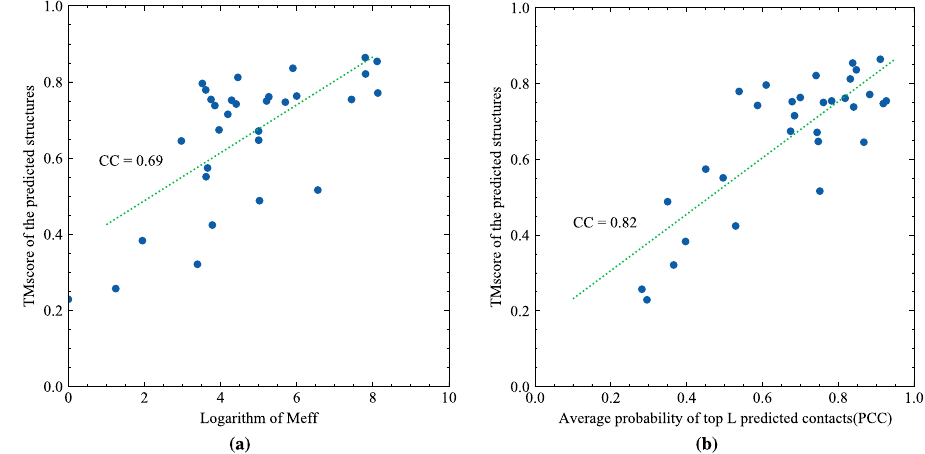
Fig. 6 Investigation of possible factors that might affect the performance of ProFOLD. Correlation between quality of the predicted structures and ( a ) M eff , ( b ) the average probability of top L predicted contacts (PPC). For the CASP13 FM target proteins, the correlation coef fi cient between M eff and TMscore of the predicted structures by ProFOLD is as high as 0.69. The correlation ef fi cient between PPC and TMscore of the predicted structures is